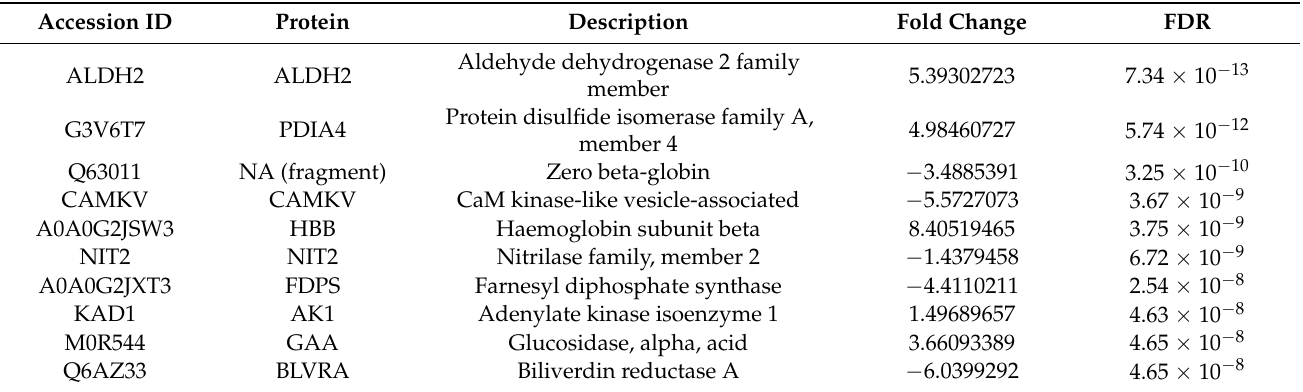
x -axis) and their statistical significance ( − log 10 ( p -value), y -axis) in GEARS relative to NEC in the ( a ) SCx and ( b ) thalamus. The upregulated proteins in GAERS compared to NEC are shown in red and downregulated proteins are in blue. ( c ) Venn diagram showing the differentially expressed proteins that are region-specific or common between SCx and thalamus of GAERS. Bottom: Dif- ferentially regulated pathways identified in the ( d ) SCx and ( e ) thalamus of GAERS, based on the PADOG analysis. The log 2 FC ( x -axis) indicates the direction of regulation (log 2 FC > 0 upregulated, log 2 FC < 0 downregulated) of the whole pathway in GAERS relative to NEC. Table 2. The top 10 differentially expressed proteins identified in the thalamus of the GAERS compared to the NEC